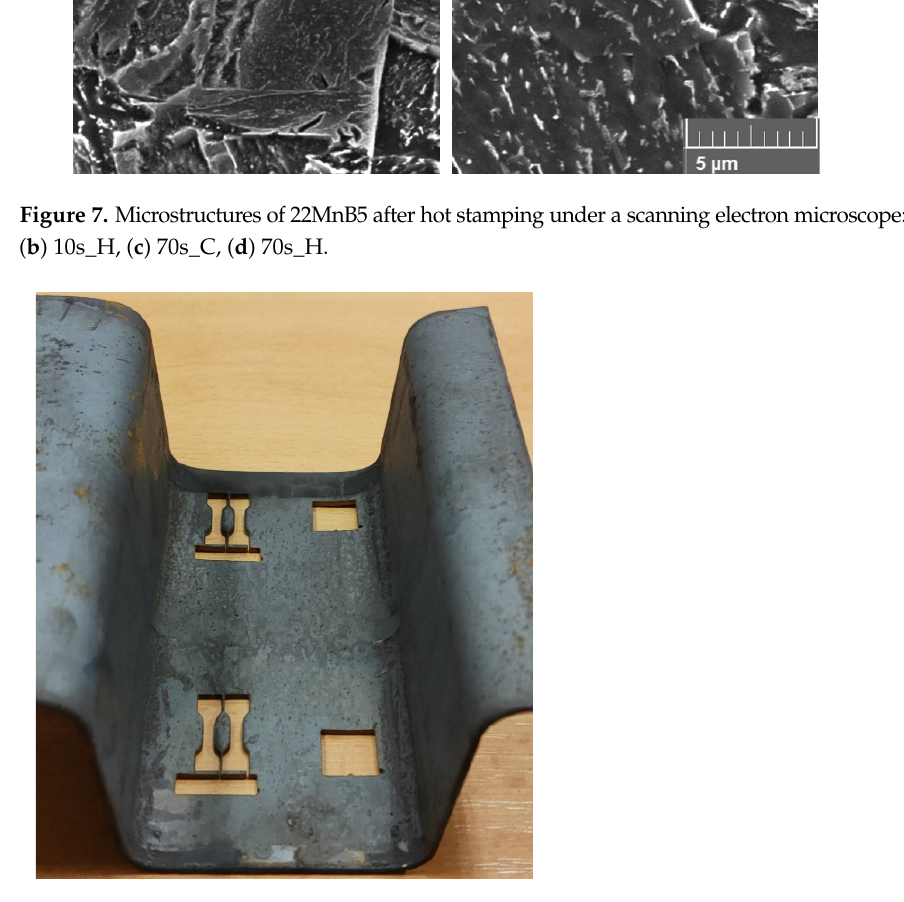
1429.6 Figure 9. Mechanical properties of 22MnB5 steel (cooled (C) and heated (H) part). Table 3 shows the HV10 hardness values with standard deviation. In 22MnB5 there was a decrease in hardness from the cooled part to the heated part. At 10 s dwell, 469 ± 7